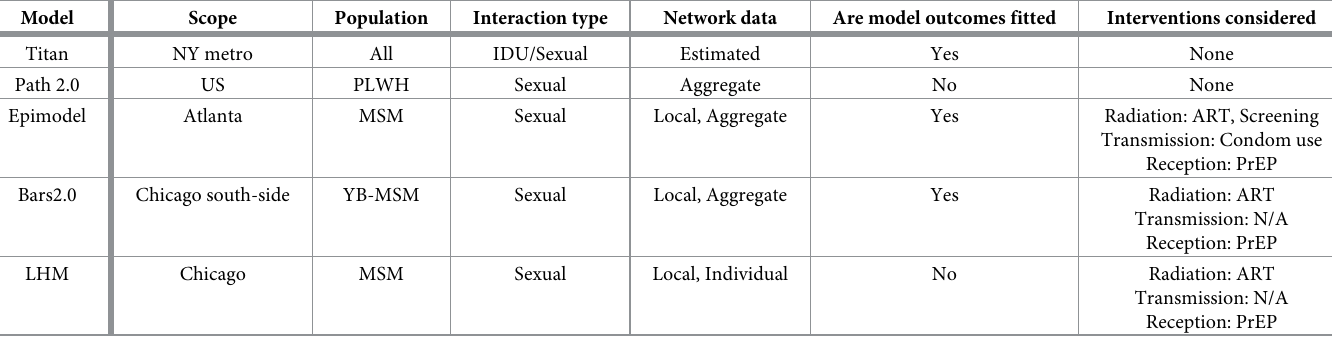
Table 1. Comparison of agent-based models for HIV